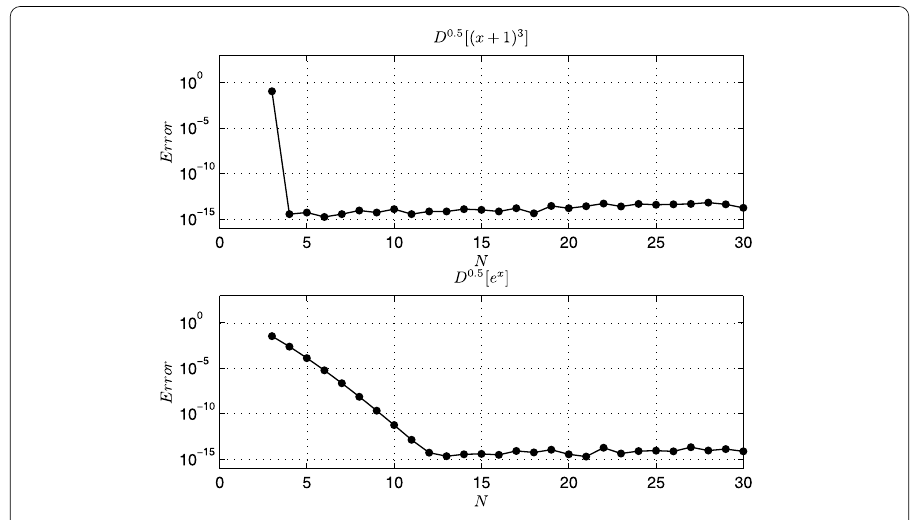
Figure 1 Accuracy of the 0.5-order Legendre spectral derivative for two functions ( x + 1) 3 and e x